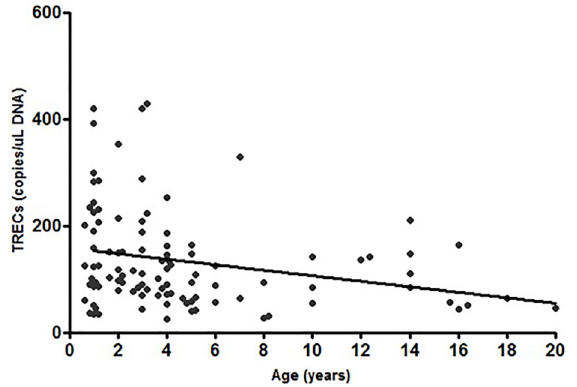
Figure 1. Levels of Tcell receptor excision circles (TRECs) per m L of DNA in healthy children and adolescents from 3 months to 20 years of age. Spearman ’ s correlation coef fi cient: rs= – 0.302,